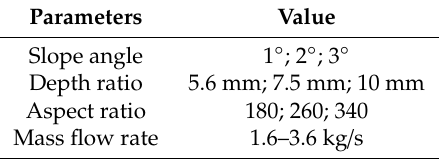
Figure 1. Computational model of thin-layer cascade (TLC) used in this study ( a ) xy-view and ( b ) xyz-view. Table 1. Summary of important parameters of the thin-layer cascade reactor used in this study.